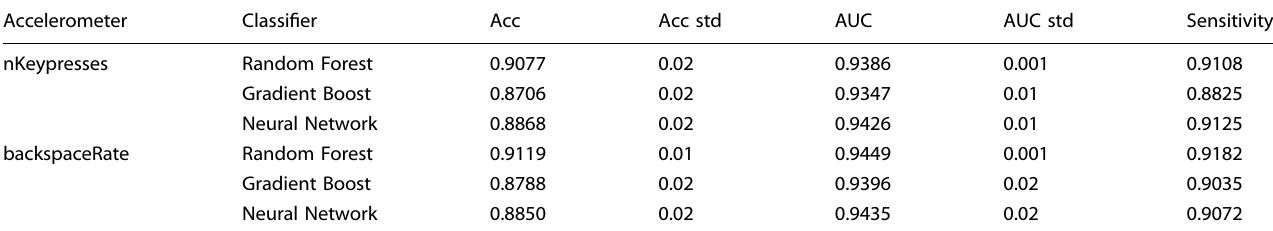
Table 5. Sensor fusion of medianX feature with typing